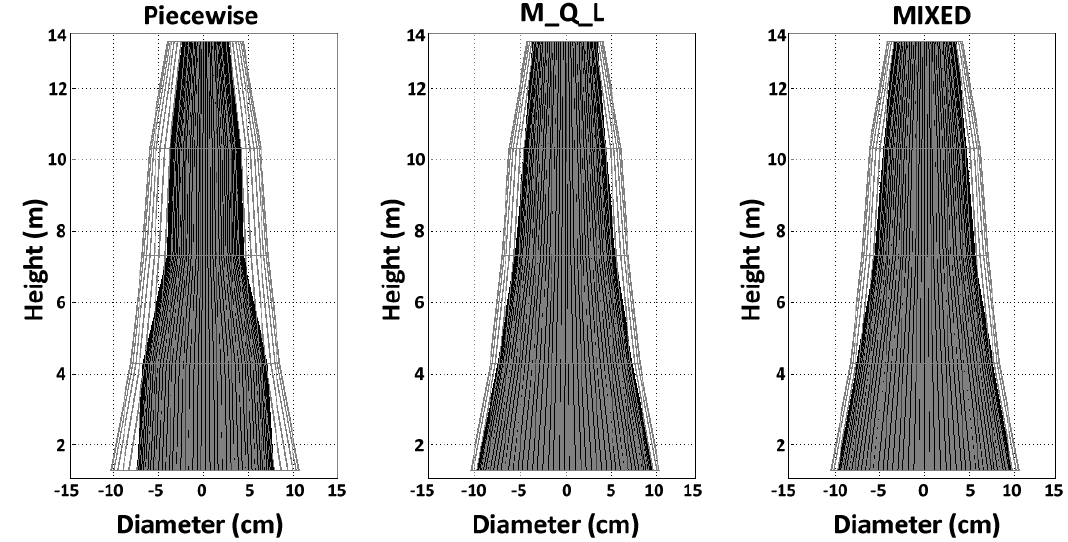
Figure 5. Graphical representation of juvenile wood (interior dark cone) and mature wood (exterior grey mesh) with transition age determined using piecewise, maximum-quadratic-linear (M_Q_L), and MIXED